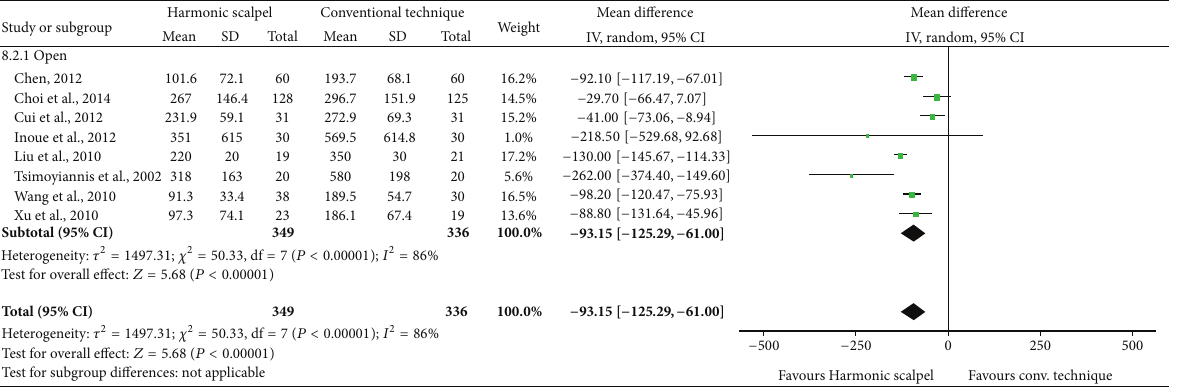
Figure 4: Forest plot of meta-analysis results for intraoperative blood loss (mL), stratified by open versus laparoscopic surgery.